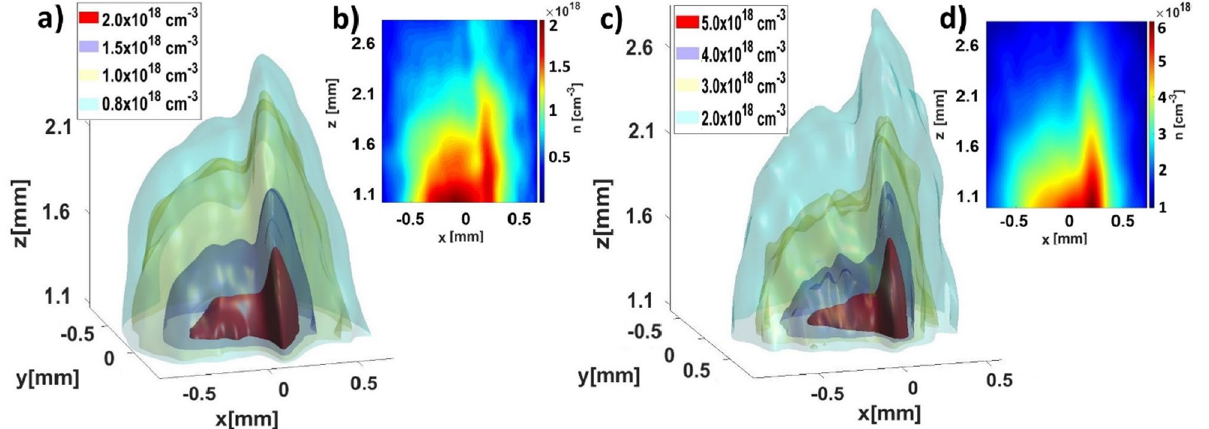
Figure 4. Tomographic density reconstructions of Ar ( a , b ) and He ( c , d ) gas jets obstructed by a razor blade placed 1 mm above the nozzle at a backing pressure of 1.6 bar and 7 bar, respectively. Gas distribution is represented by density isosurfaces with values shown in the legend. The z-coordinate describes the height above the nozzle. Vertical cross-sections of the density profiles in the middle of the gas jet (plane y = 0) is shown in the insets ( b ) and ( d ) for Ar and He, respectively.